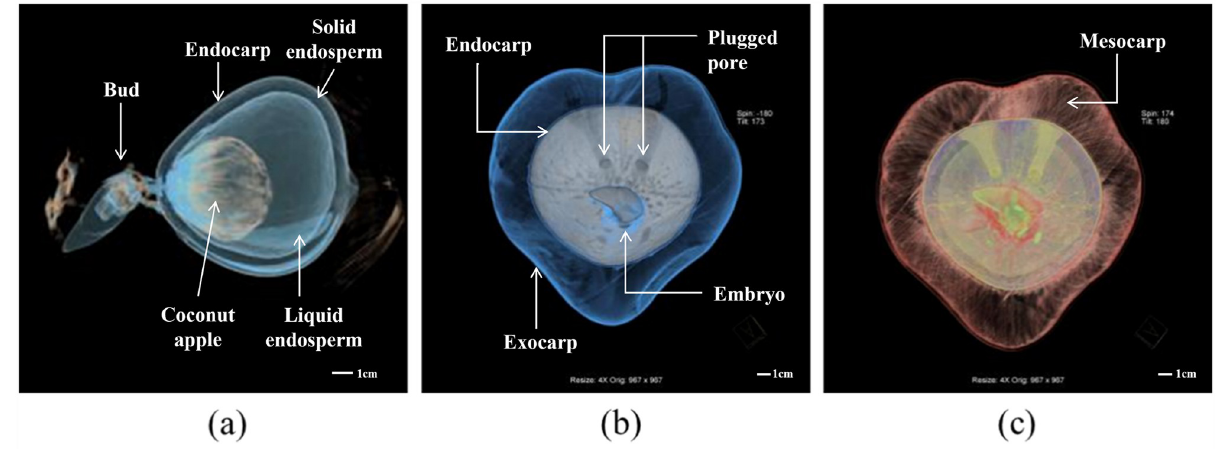
Fig 4. Different volume rendering models for displaying different structures on one coconut: Exocarp, mesocarp, endocarp, coconut apple, endosperm, and buds.